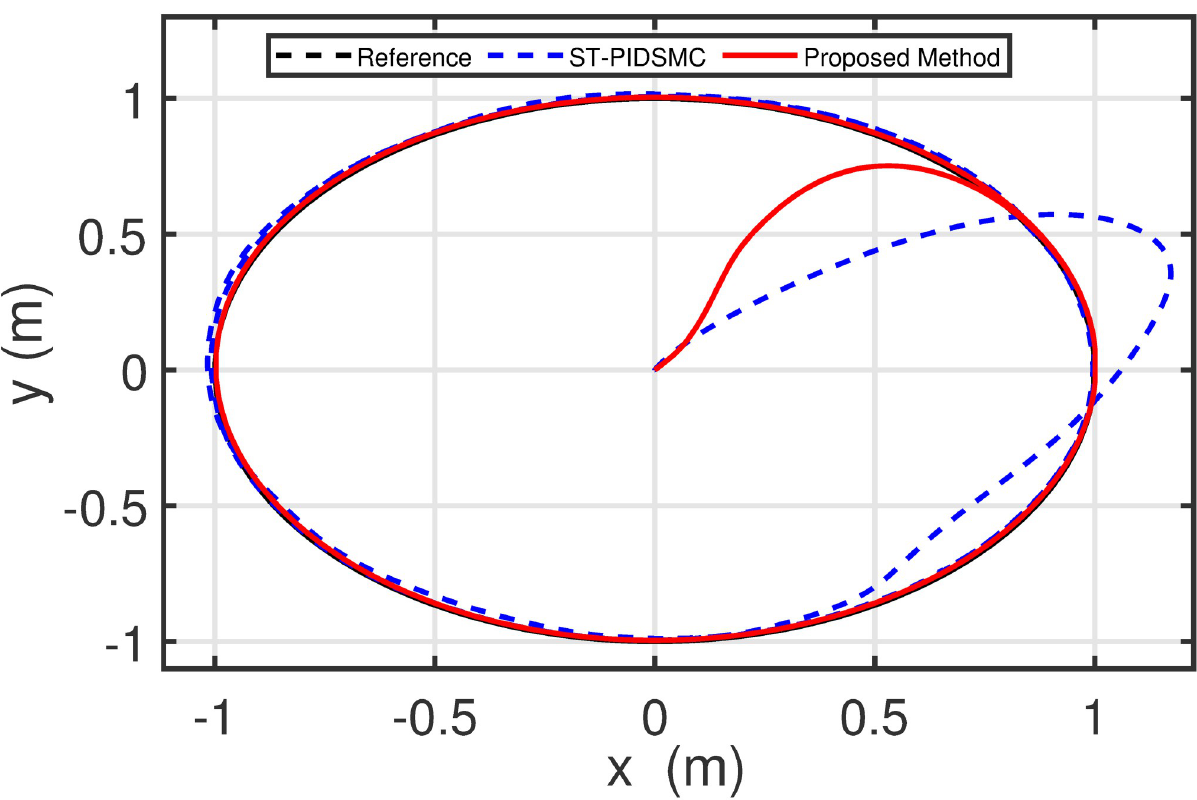
Fig 20. Results of the path following in 3D space under the proposed controller.